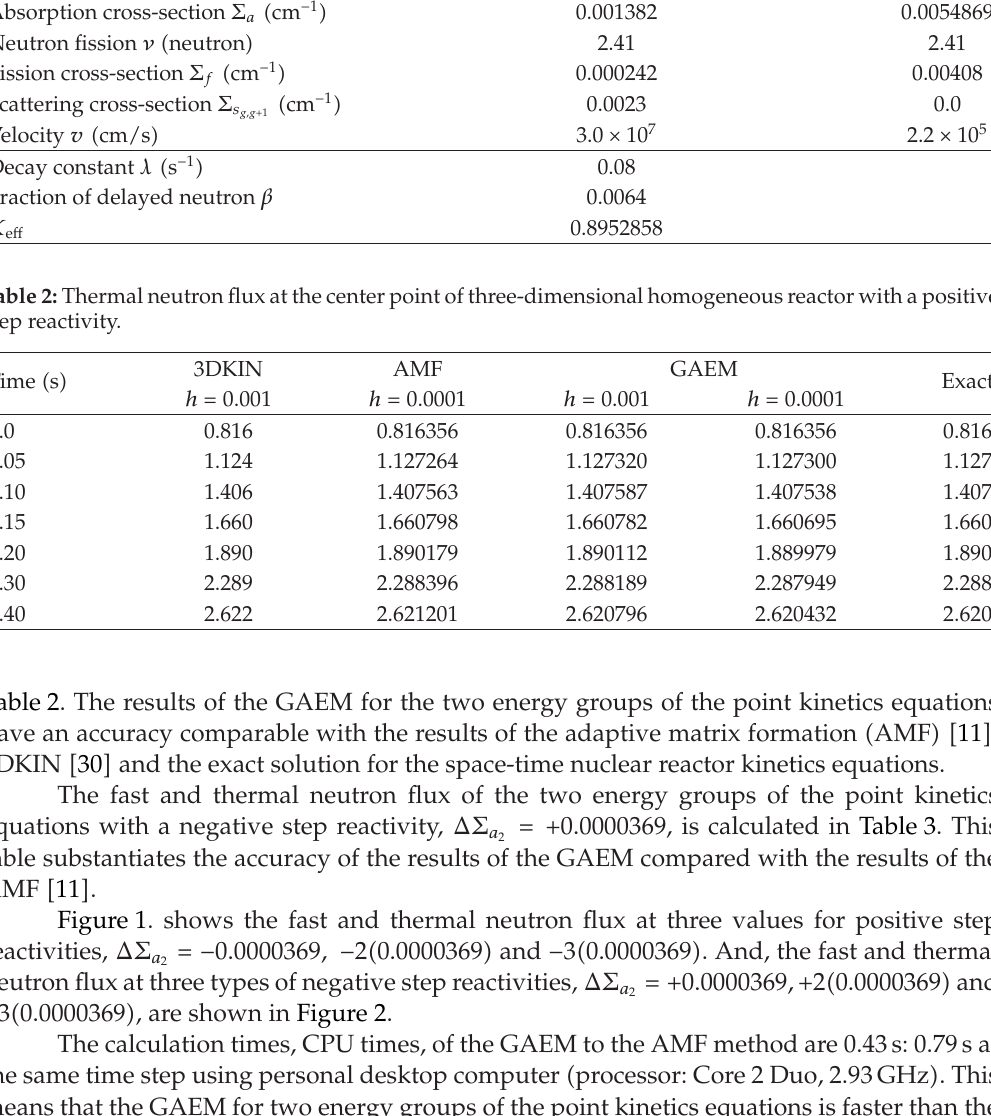
Table 1: Parameters of three-dimensional homogeneous reactor (cid:6) 11 (cid:7) . Parameter Group 1 Group 2